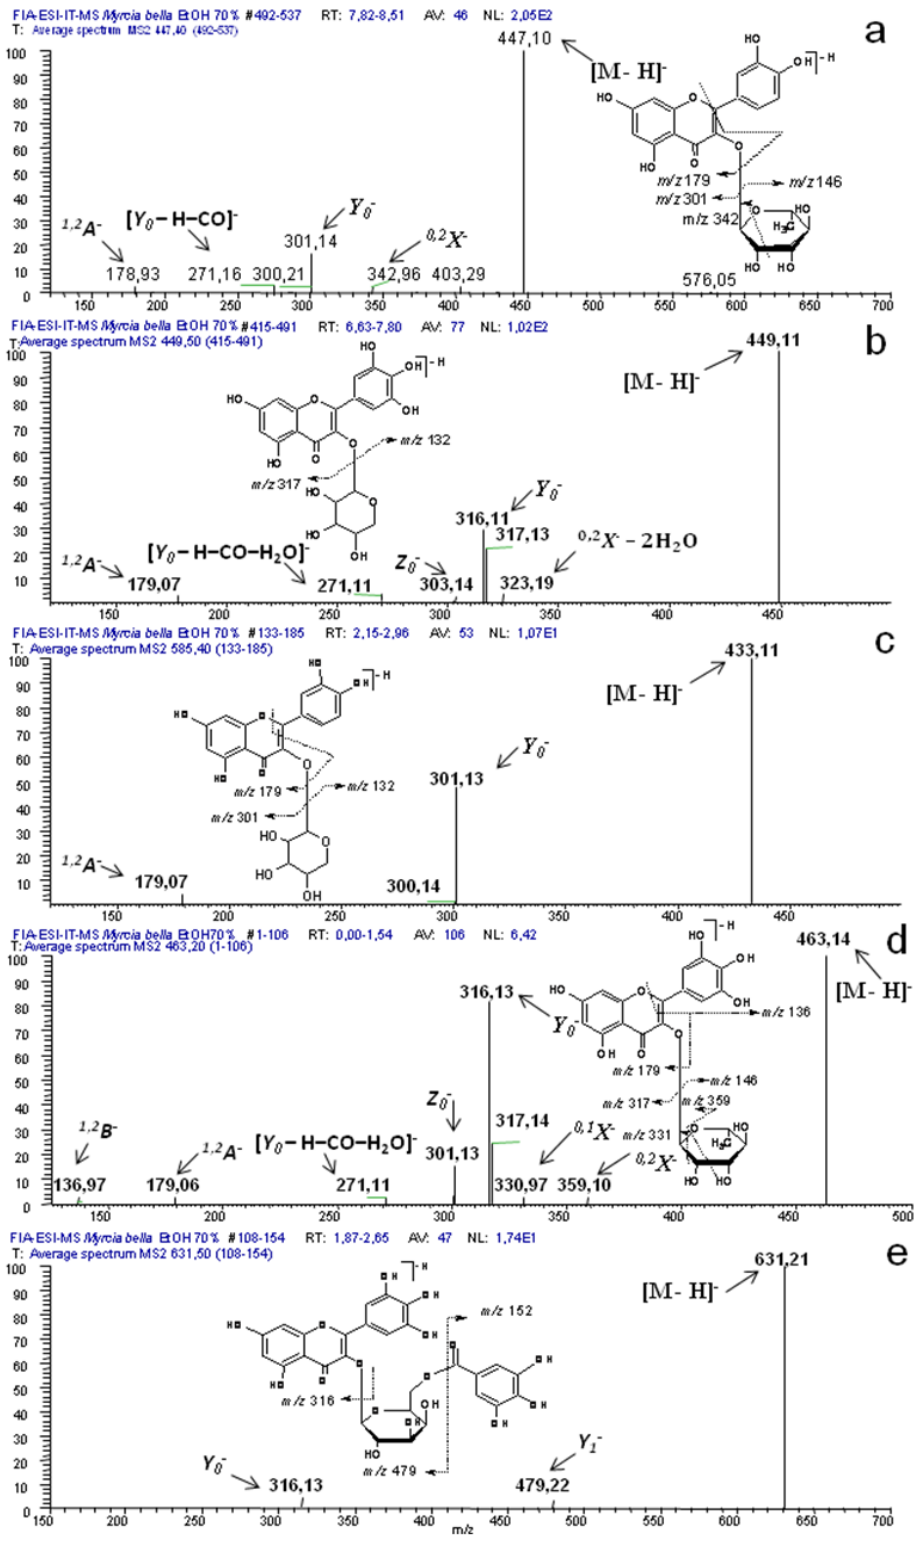
Figure 4. Second-generation product ion spectra obtained for the main precursor ions produced in the FIA-ESI-MS experiment and the proposed fragmentation. For conditions, see the Experimental